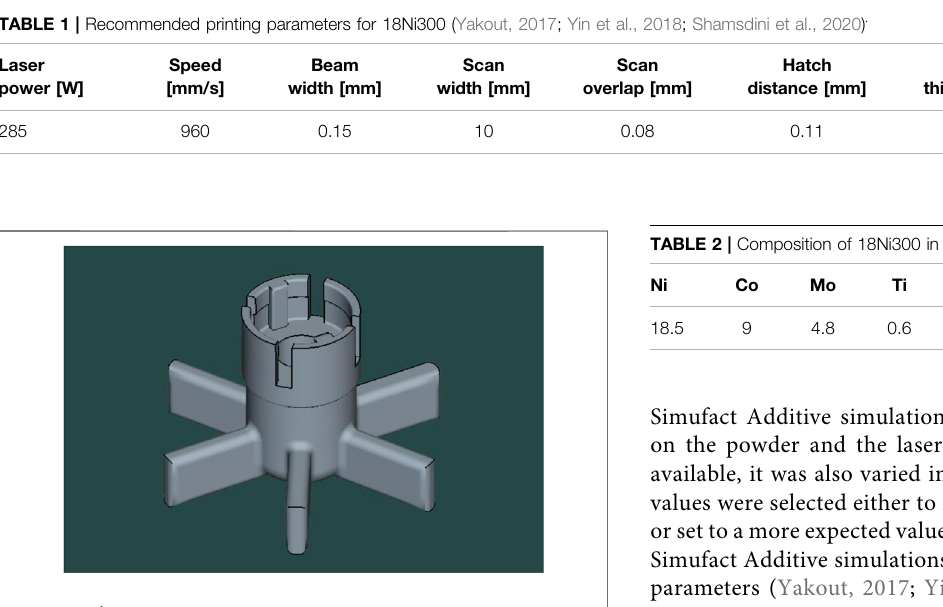
FIGURE 1 | Part geometry used in the Simufact Additive simulations.